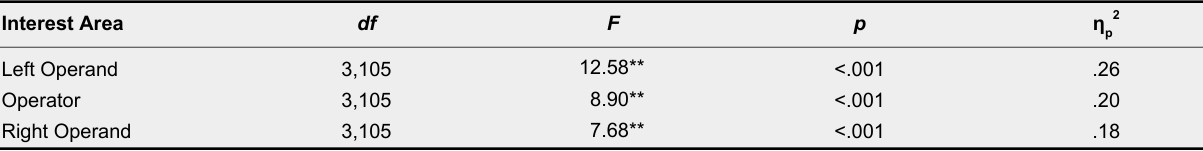
Separate Analyses of Proportion of First Fixations to Each Interest Area: The Independent Variable for Each Analysis is